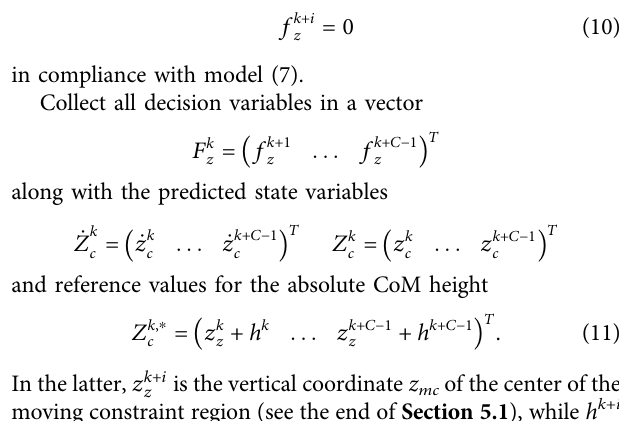
FIGURE 5 | A schematic visualizing the time discretization as well as the two horizons used in the scheme.